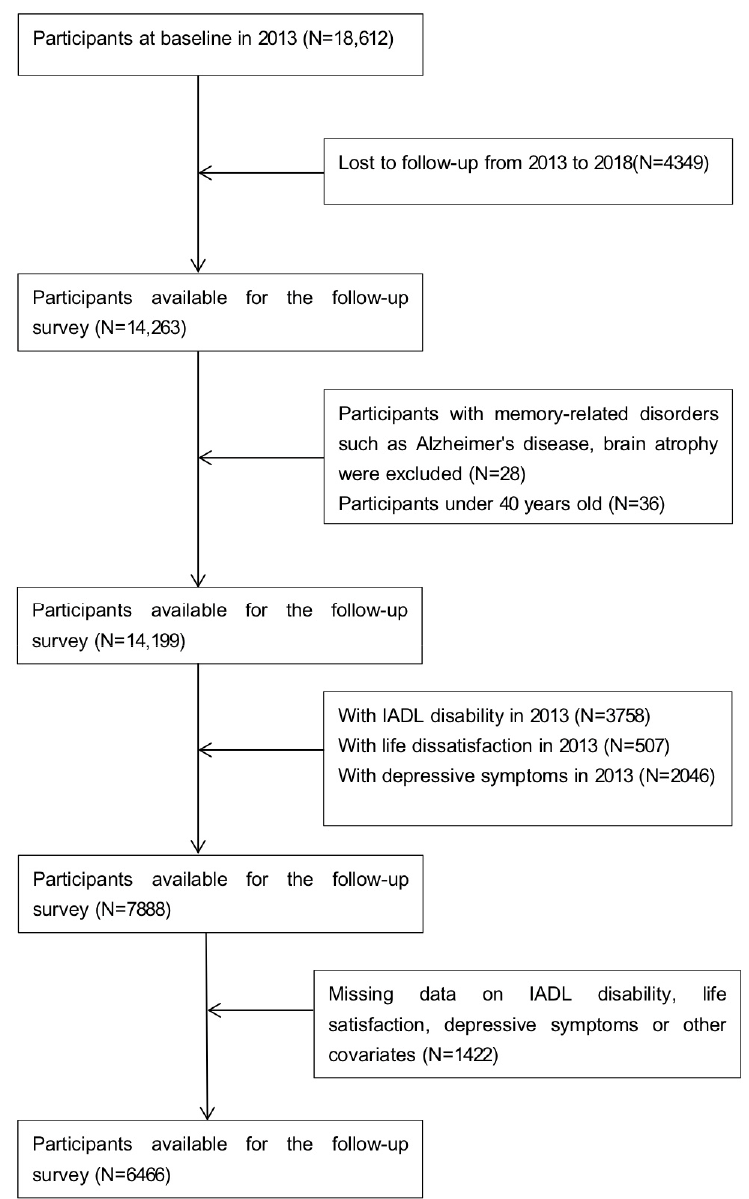
Figure 1. Flowchart of the inclusion of participants.